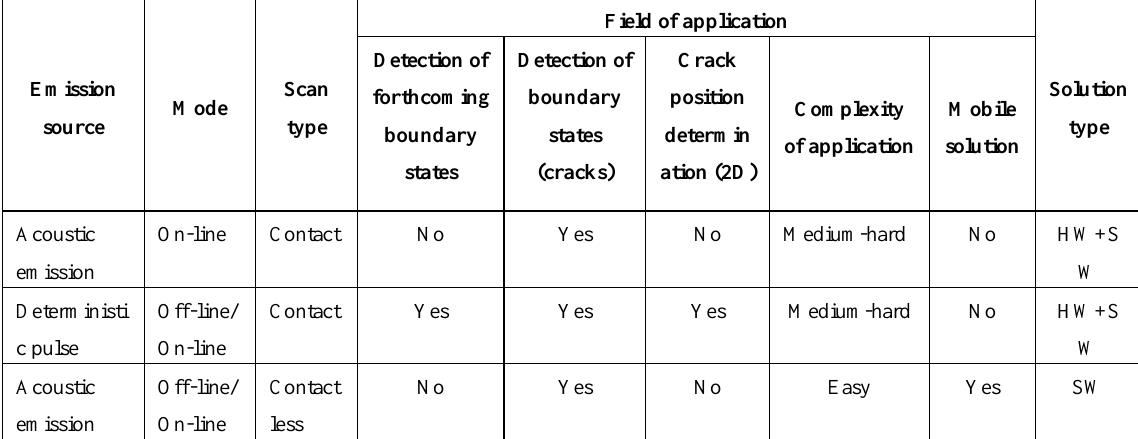
Table 1. Summarized comparison of several relevant methods for internal defect